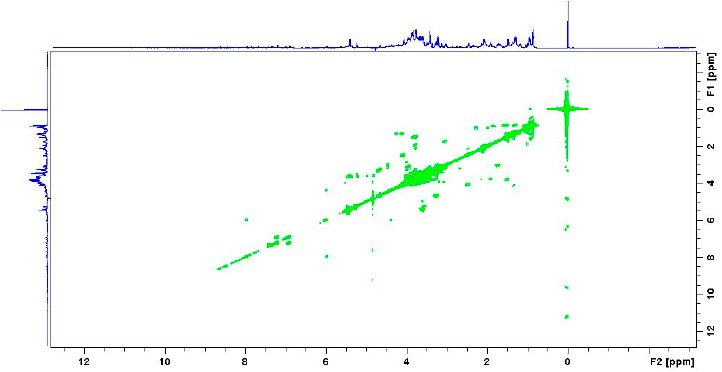
Figure 3. 2D COSY 1 H spectra of the Daphia sample from Figure 1 illustrating cross peaks.